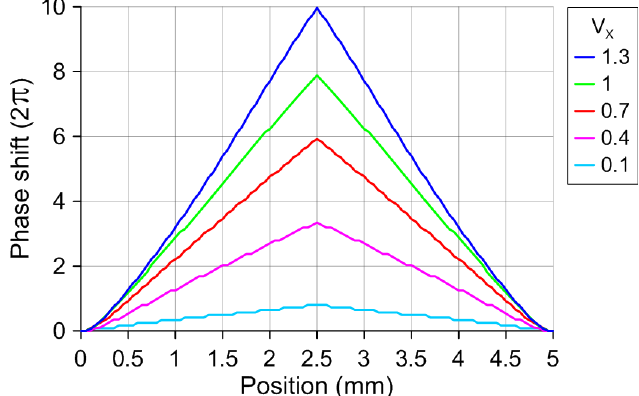
Figure 5. Phase shift profile in the XZ plane for several voltages applied to the